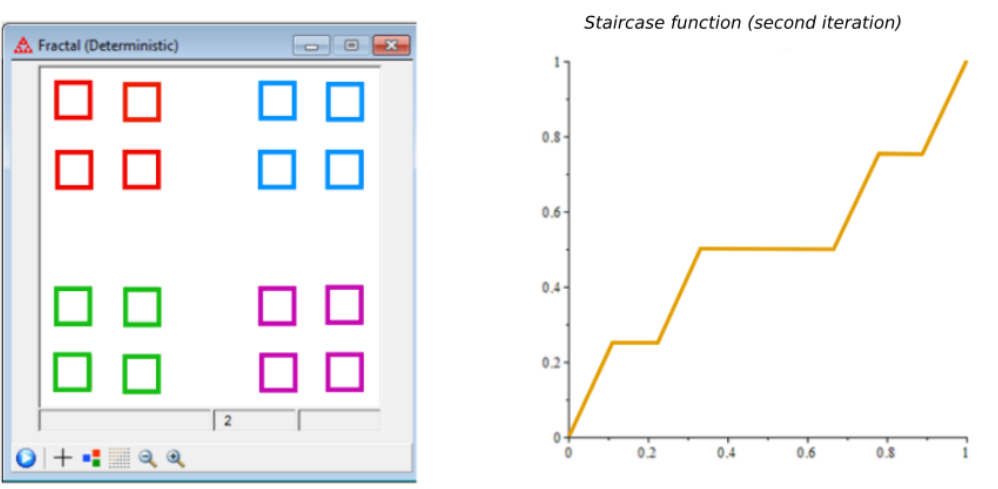
Figure 2. Staircase function for the first iteration.